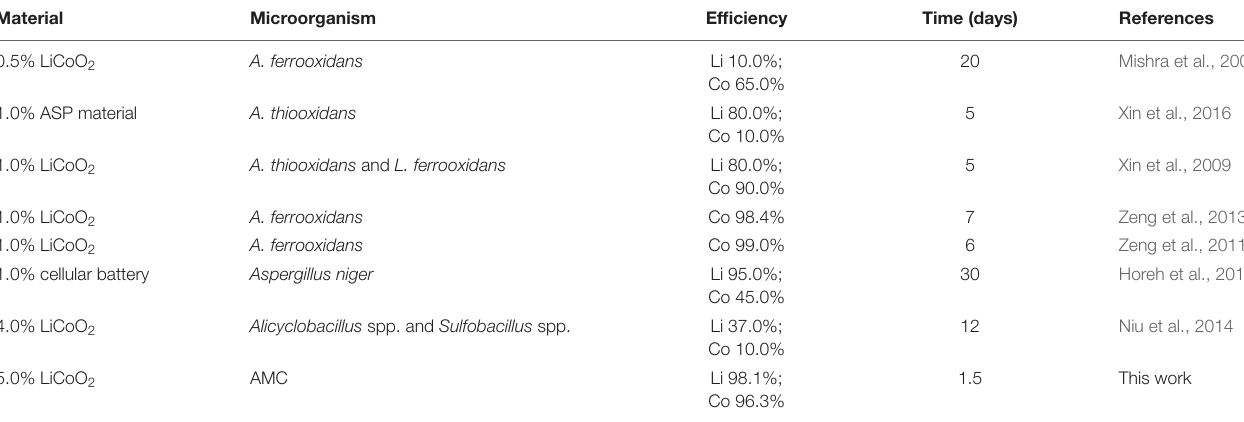
TABLE 1 | Comparison of this study with published data on the bioleaching of LiCoO 2 .